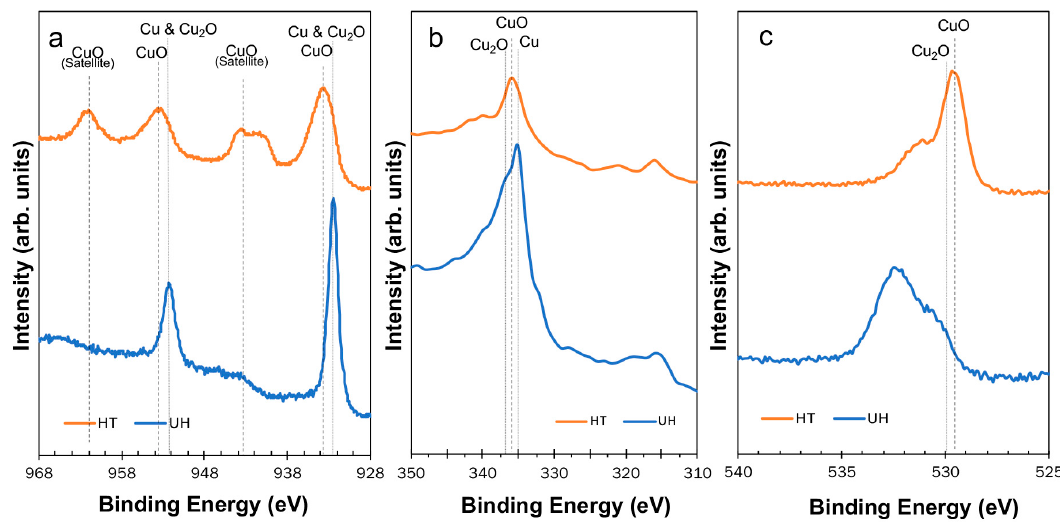
Figure 4. XPS narrow scan spectra of Cu 2p region ( a ), Cu LMM ( b ), and O 1s region ( c ) of the Cu plates.